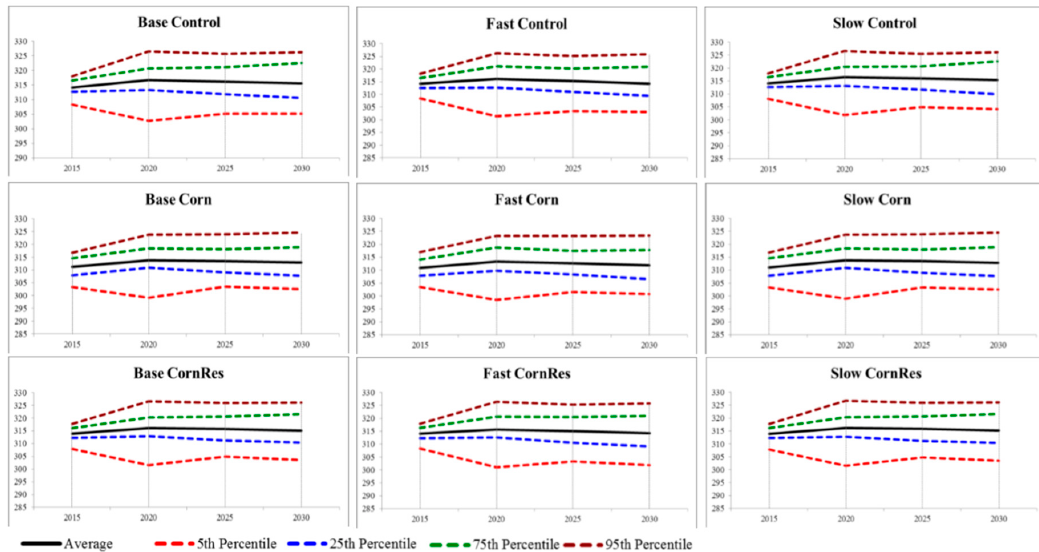
Figure A2. Variability of U.S. cropland used for crop production (in million acres) stochastic draw during 2015 to 2030 under various biofuel policy and demand growth scenarios.